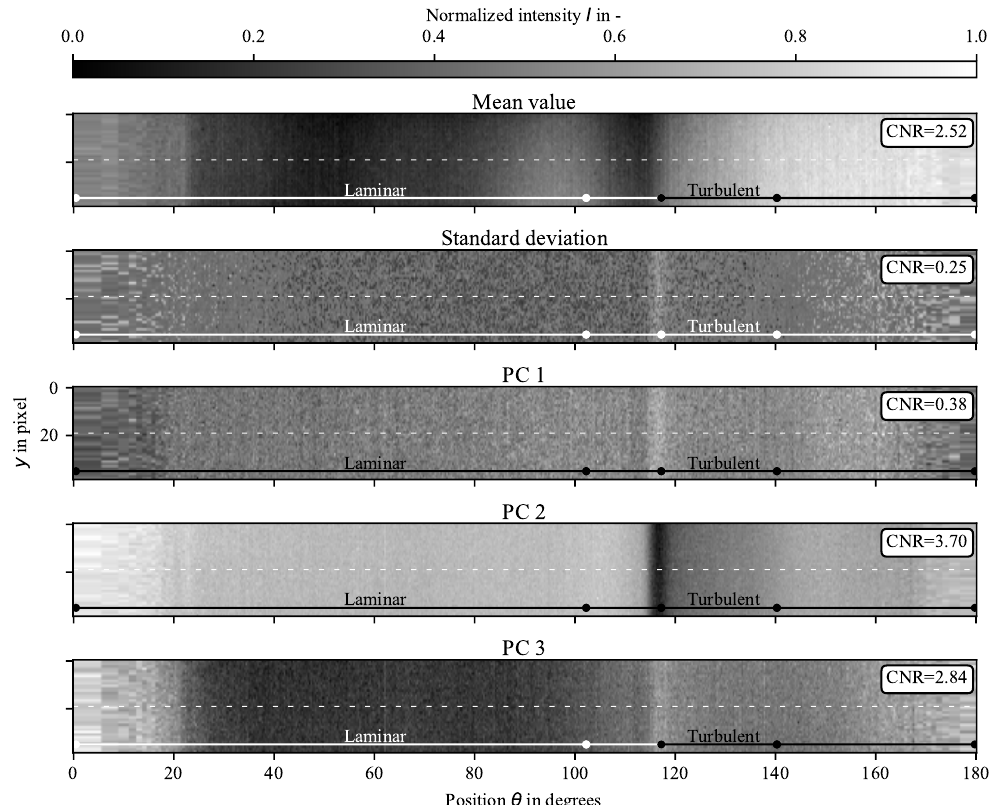
Figure 5. Thermographic flow visualization of the cylinder object in cross-flow with a Reynolds number of 5.2 × 10 5 . Temporal mean value and temporal standard deviation as well as principal components (PC) no. 1–3 from the PCA of the image series. Systematic inhomogeneities in the flow regimes are reduced while a contrast between the laminar and turbulent flow regime is maximized in PC 2 with CNR =